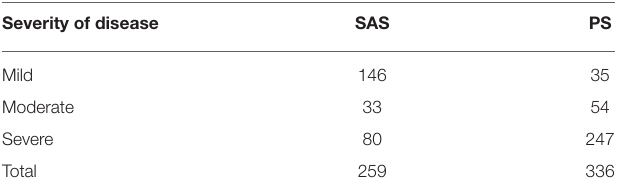
TABLE 1 | Number of cases diagnosed with subvalvular aortic stenosis (SAS) or pulmonic stenosis (PS) based on continuous-wave doppler echocardiogram